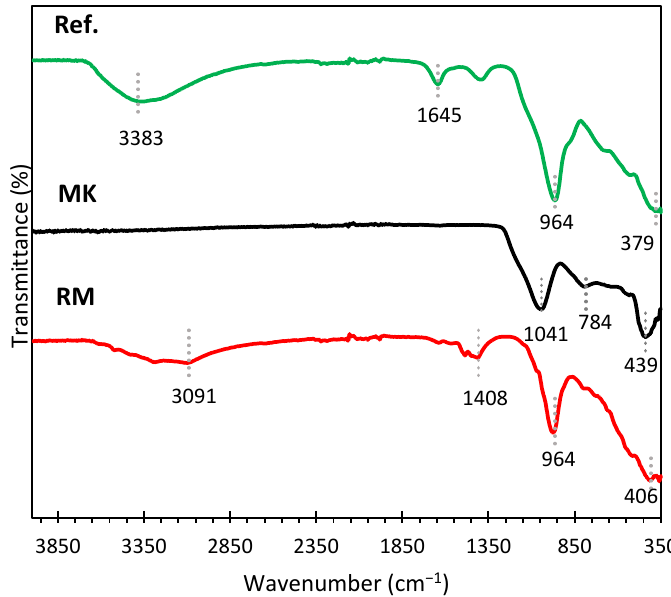
Figure 3. FTIR spectra of raw materials and reference sample.